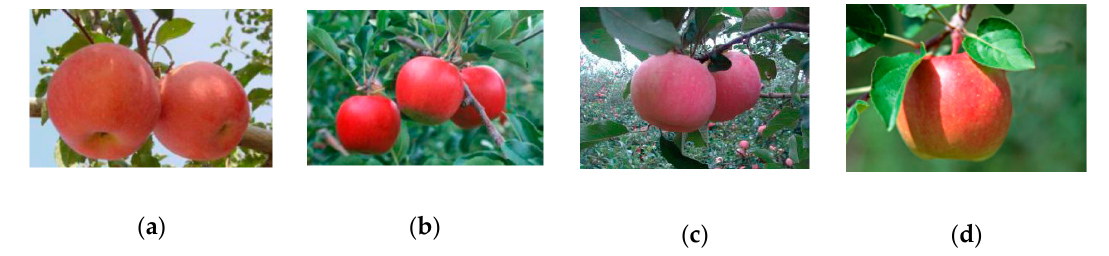
Figure 1. Captured apple images. ( a )– ( c ) overlapped images; ( d ) shaded image.